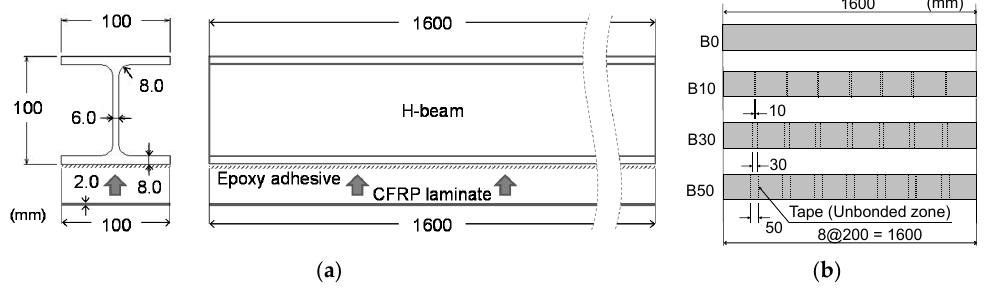
Figure 1. Beam details: ( a ) side view; ( b ) bottom view.